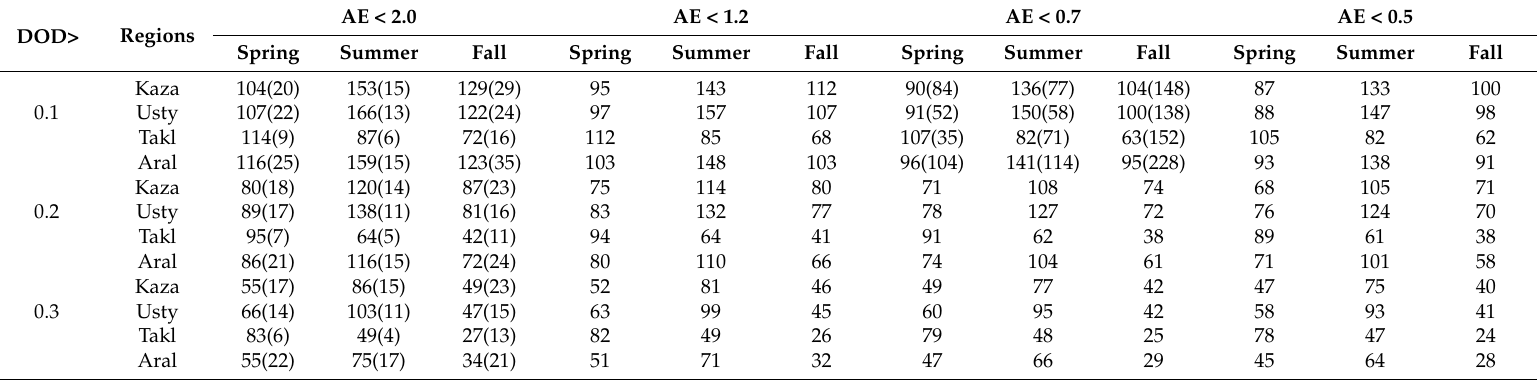
Table 2. Dust occurrence numbers for four sub-regions (Kaza: Kazandzhik; Usty: Ustyurt Plateau; Takl: Taklimakan; Aral: Aral Kum), as labeled by the purple boxes in Figure 1, with three different DOD thresholds (0.1, 0.2, and 0.3) and four Angstrom exponent thresholds (2.0, 1.2, 0.7 and 0.5). The last two Angstrom exponent thresholds correspond to Criterion 2 and Criterion 1, respectively. All quality levels from MODIS/Terra are used. Note numbers in parenthesis of the first three columns represent relative percentages (%) between dust occurrence numbers with AEt = 0.2 and those with AEt = 0.5. Similarly, numbers in parenthesis from column 7 to column 7 represent relative percentages (%) between dust occurrence numbers with DODt = 0.1 and those with DODt = 0.3 for AEt =